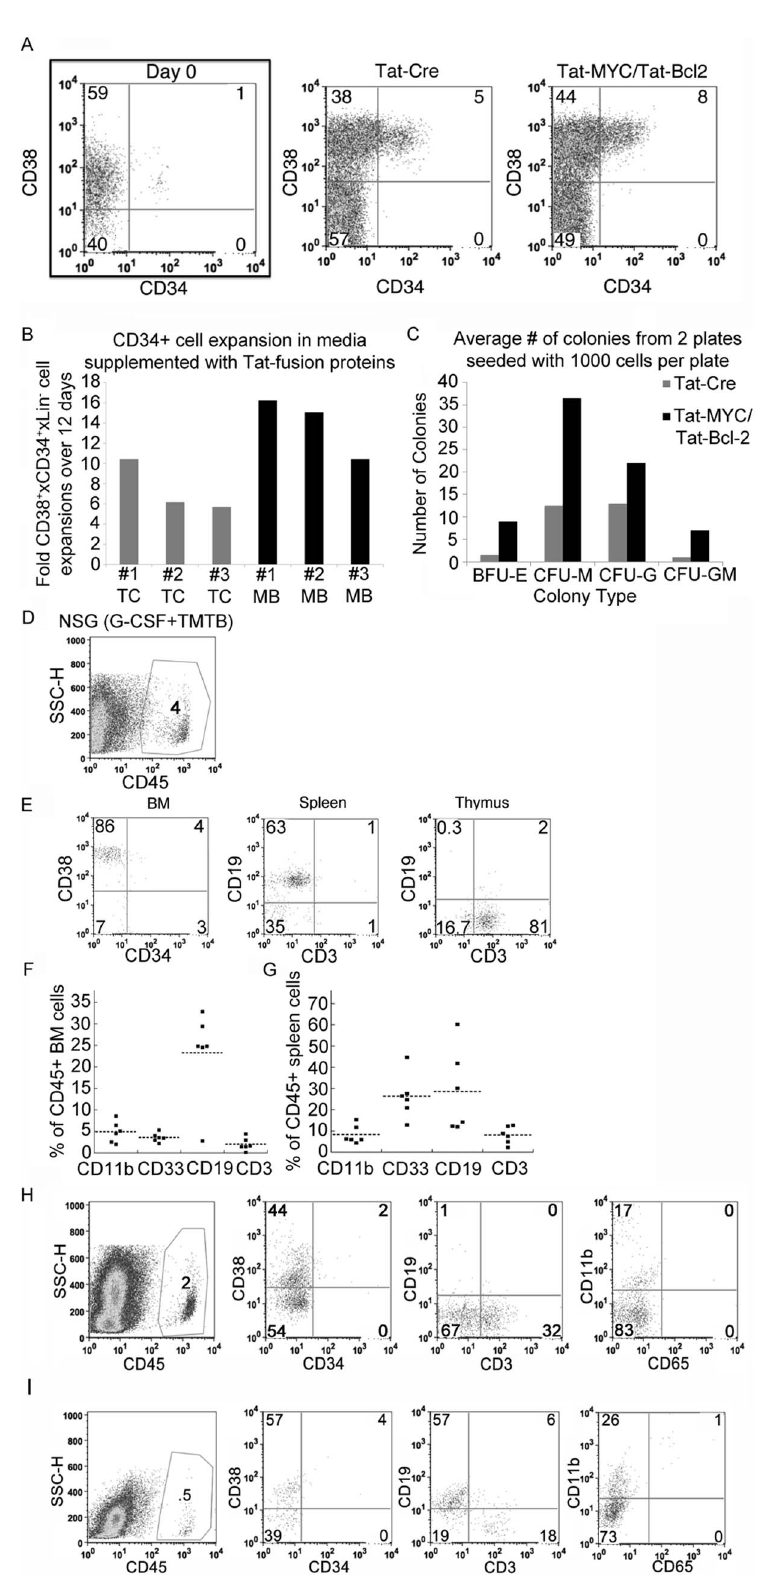
Figure 8. Expansion of adult human G-CSF mobilized blood cells exvivo with Tat-MYC/Tat-Bcl-2. Blood cells from a G-CSF mobilized patient were cultured in CB media the presence of Tat-Cre or Tat-MYC/Tat-Bcl-2 for 12 days. A. The flow cytometry panels showing the percent CD34 + cells in culture on day 0 and day12 days of expansion in CB media supplemented with Tat-Cre or Tat-MYC/Tat-Bcl-2. B. Graphical representation of the CD34 + cells expanded from three independent G-CSF mobilized patient samples. Each sample was split in half and treated with